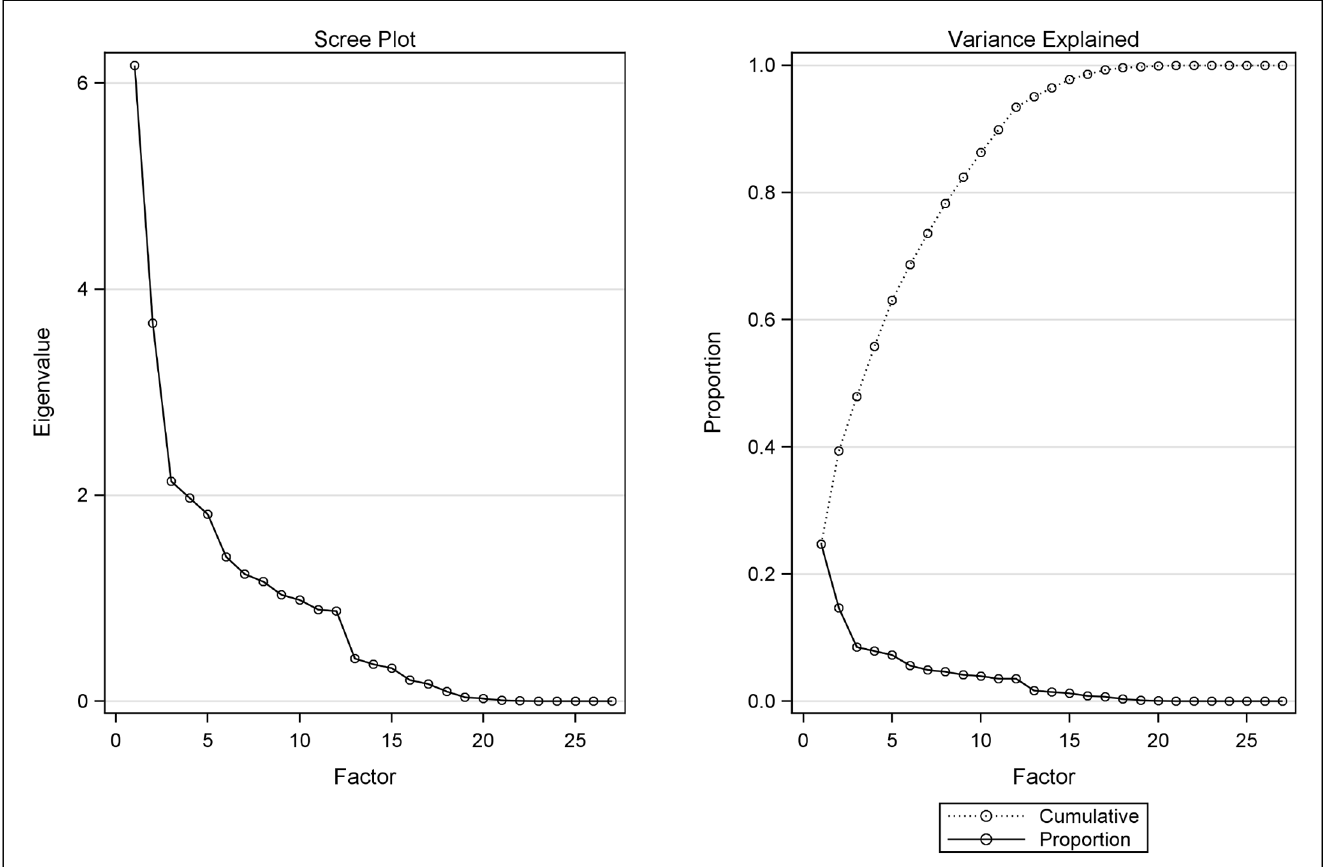
Fig 1. Cumulative and individual proportion of varianceexplained by each lifestyle and environmental factors in factor analysis. Figure located on the left shows a scree plot that displaysthe eigenvaluesthat each factor associatedwith. Figure locatedon the right shows proportionof variance each factor and cumulative of all factors explainedin the